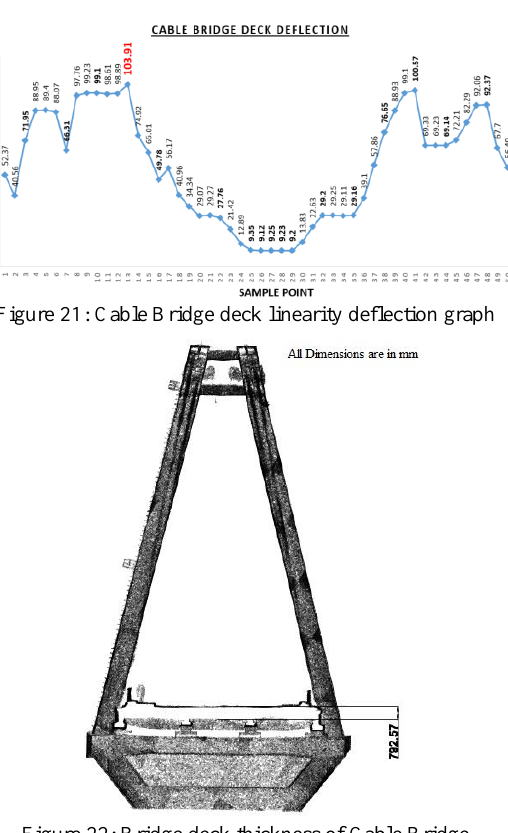
Figure 22: Bridge deck thickness of Cable